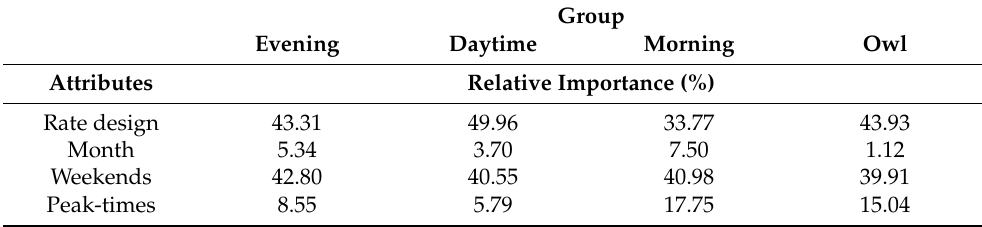
Table 6. Relative importance of attribute by